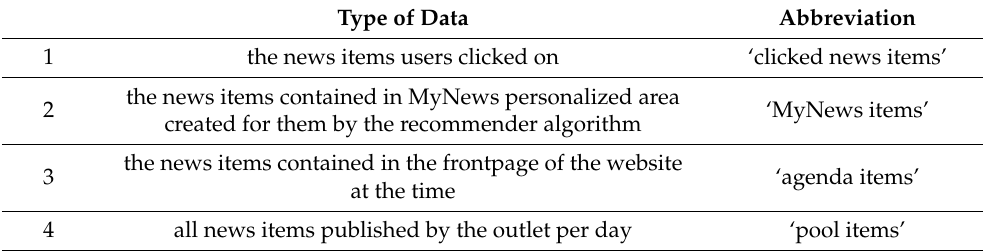
Table 1. Type of data collected.